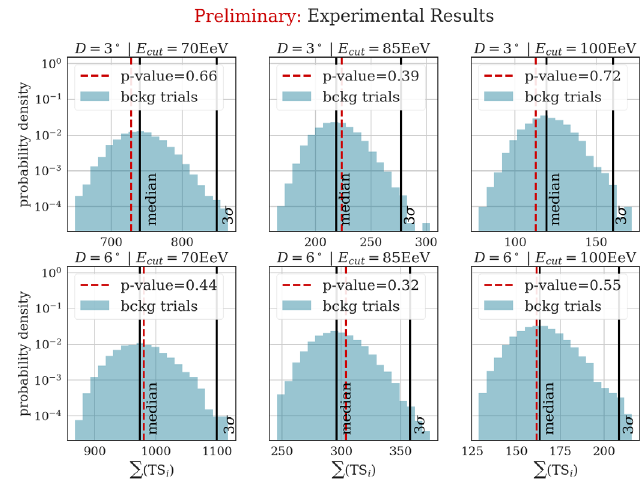
Figure 1. Experimental results (red dashed line) w.r.t. the corresponding background test statistic distribution (blue histogram), where the background median and the 3 σ quantile have been marked (black lines). The magnetic deflection parameter D and the energy cut on the UHECRs are given in the